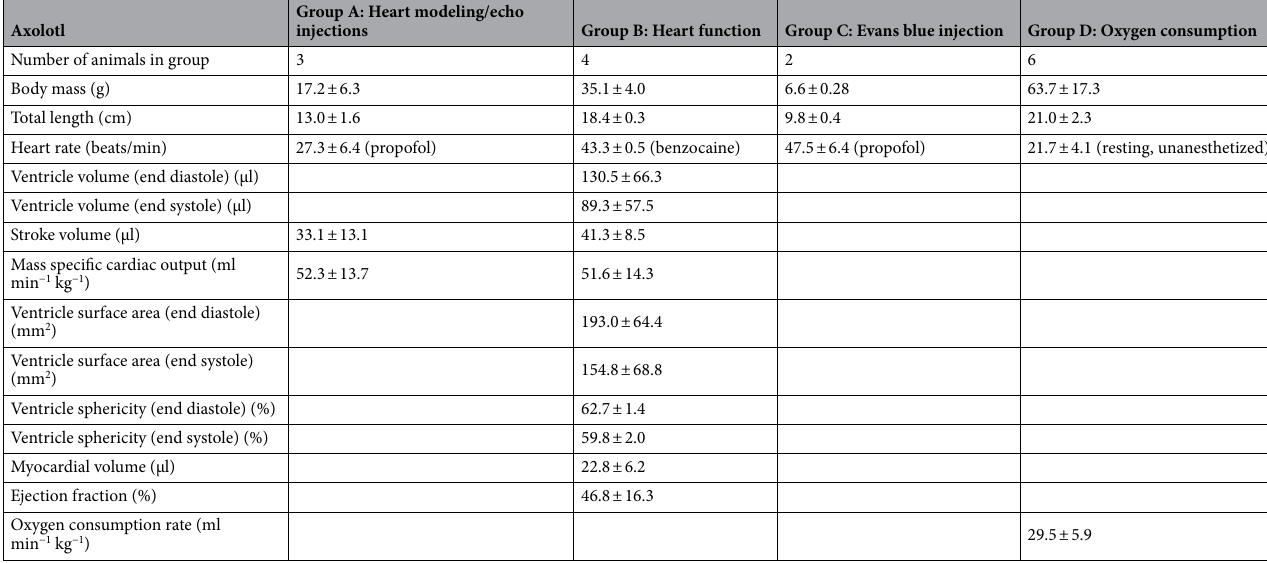
Table 1. Characteristics and measured physiological parameters of the used